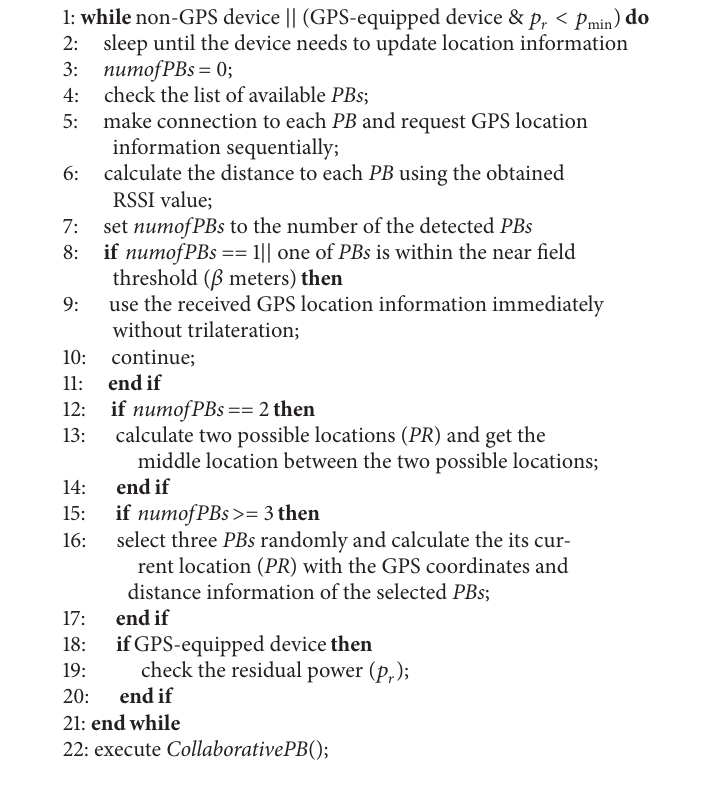
Algorithm 3: ECOPS: CollaborativePR